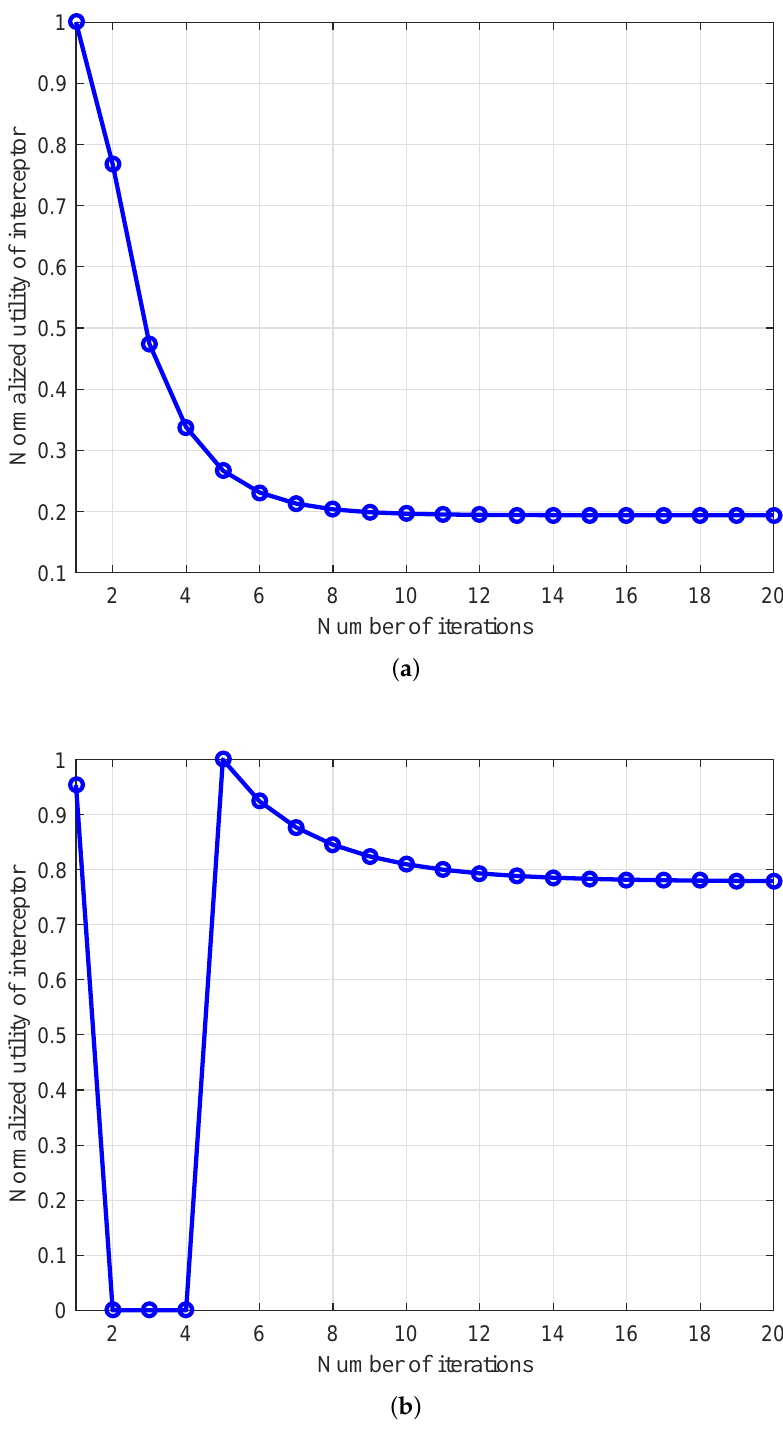
Figure 8. Convergence behavior for the normalized utility of intercept receiver in the first case: ( a ) Target position is [ 0,0 ] km; ( b ) Target position is [ − 30, − 40 ]